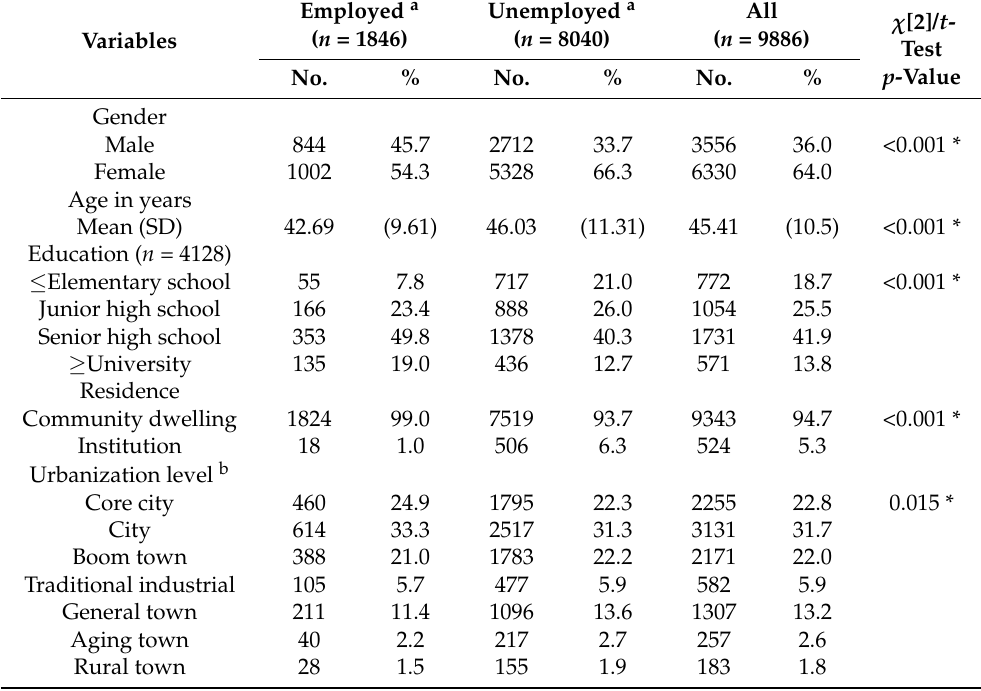
Table 1. Demographic characteristics of the subjects ( n =